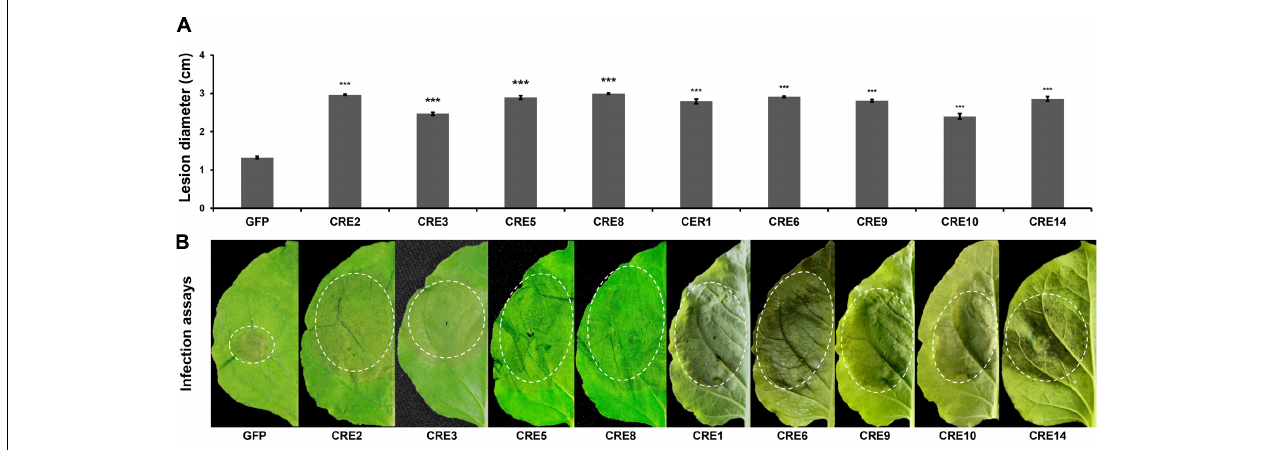
FIGURE 3 | Transient overexpression of selected RXLR effector genes enhances P . infestans colonization. (A) Average lesion diameters of the inoculated leaves. Error bars represent standard errors calculated from at least 30 independent biological replicates. Asterisks indicate significant differences determined using Dunnett’s test ( P < 0.005), (B) N . benthamiana leaf phenotypes upon P . infestans infection. Detached leaves of GFP - and RXLR effector-transgenic plants were inoculated with P . infestans zoospores. These representative photographs were taken at 120